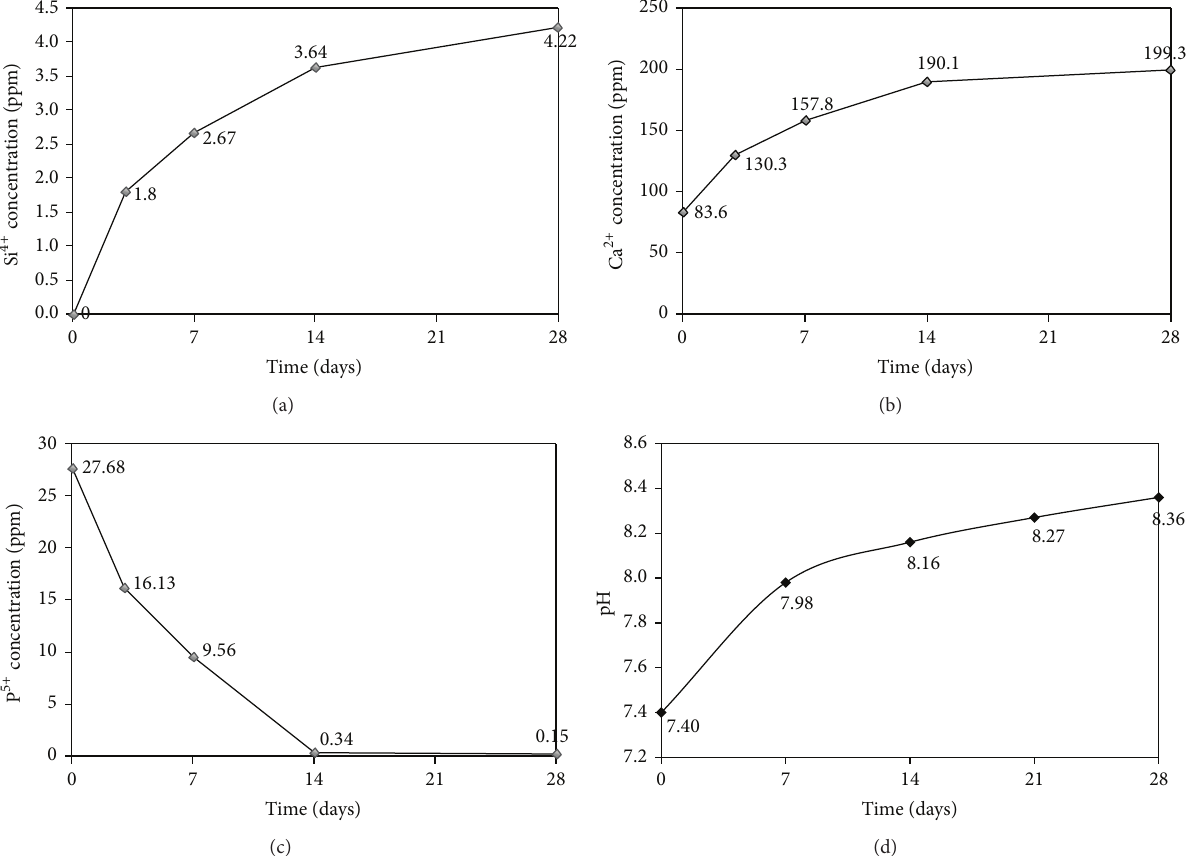
Figure 9: Changes in ion concentration, (a) Si 4+ ion, (b) Ca 2+ ion, and (c) P 5+ ion, and (d) pH of the SBF solution, after soaking AW95 (sintered at 1100 ∘ C for 2h) at various time intervals during bioactivity